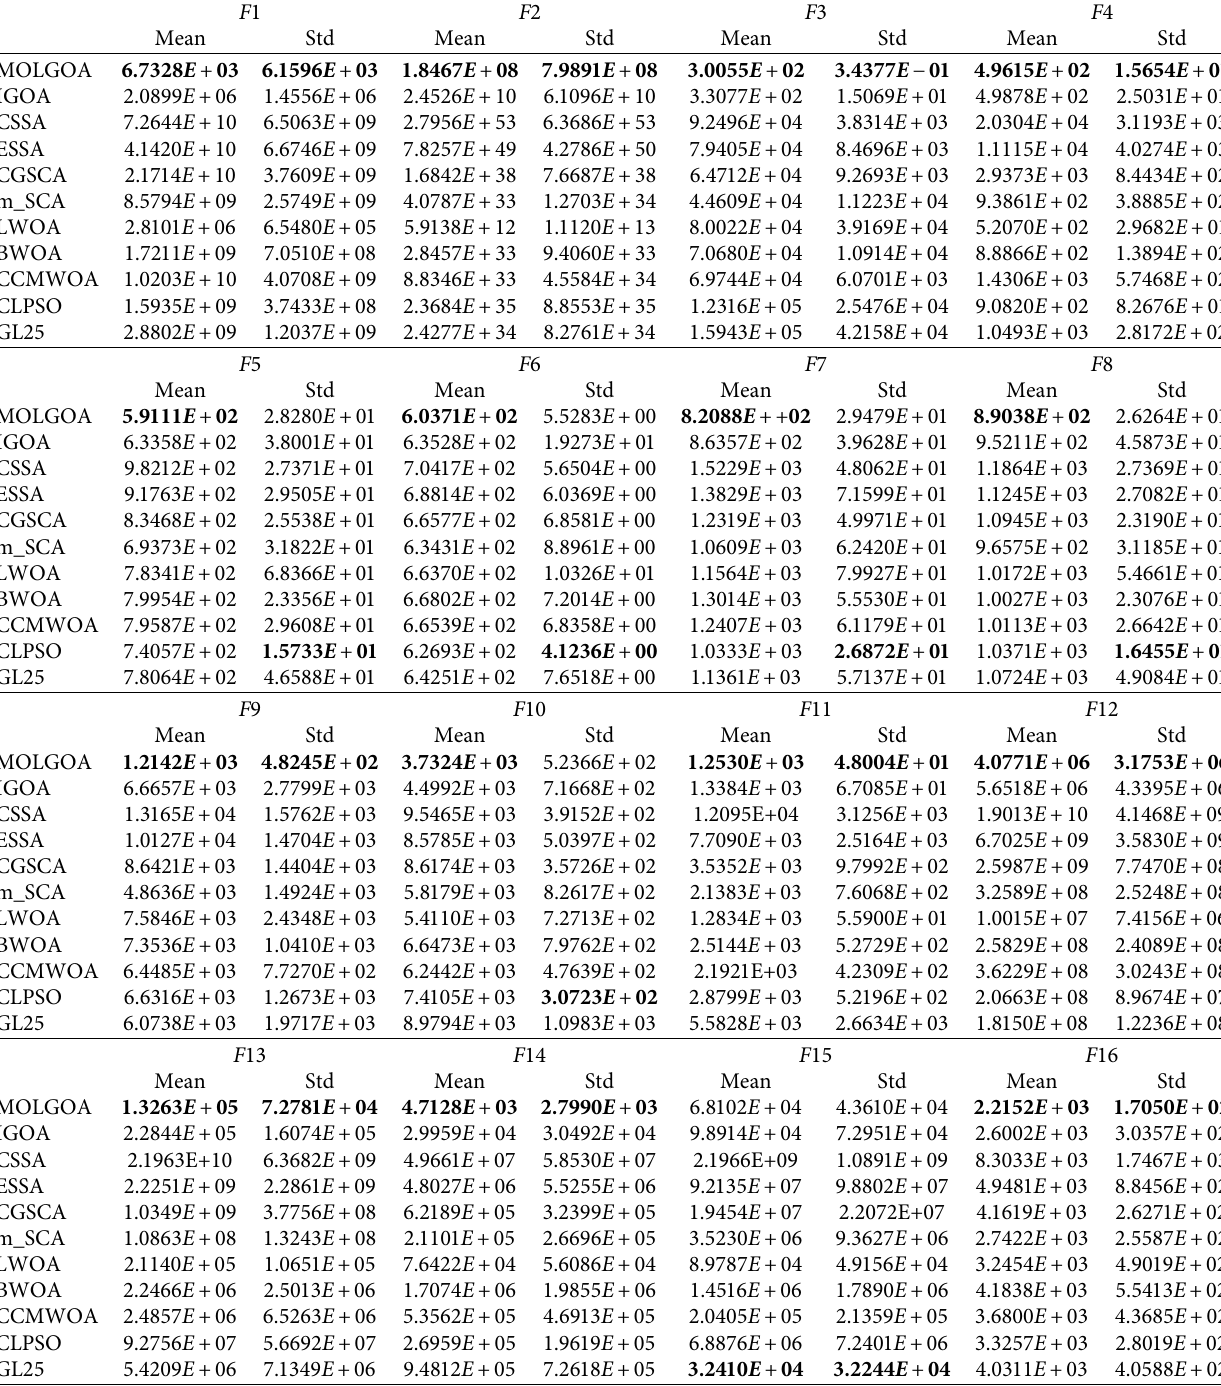
Table 9: Comparison results of MOLGOA and other advanced